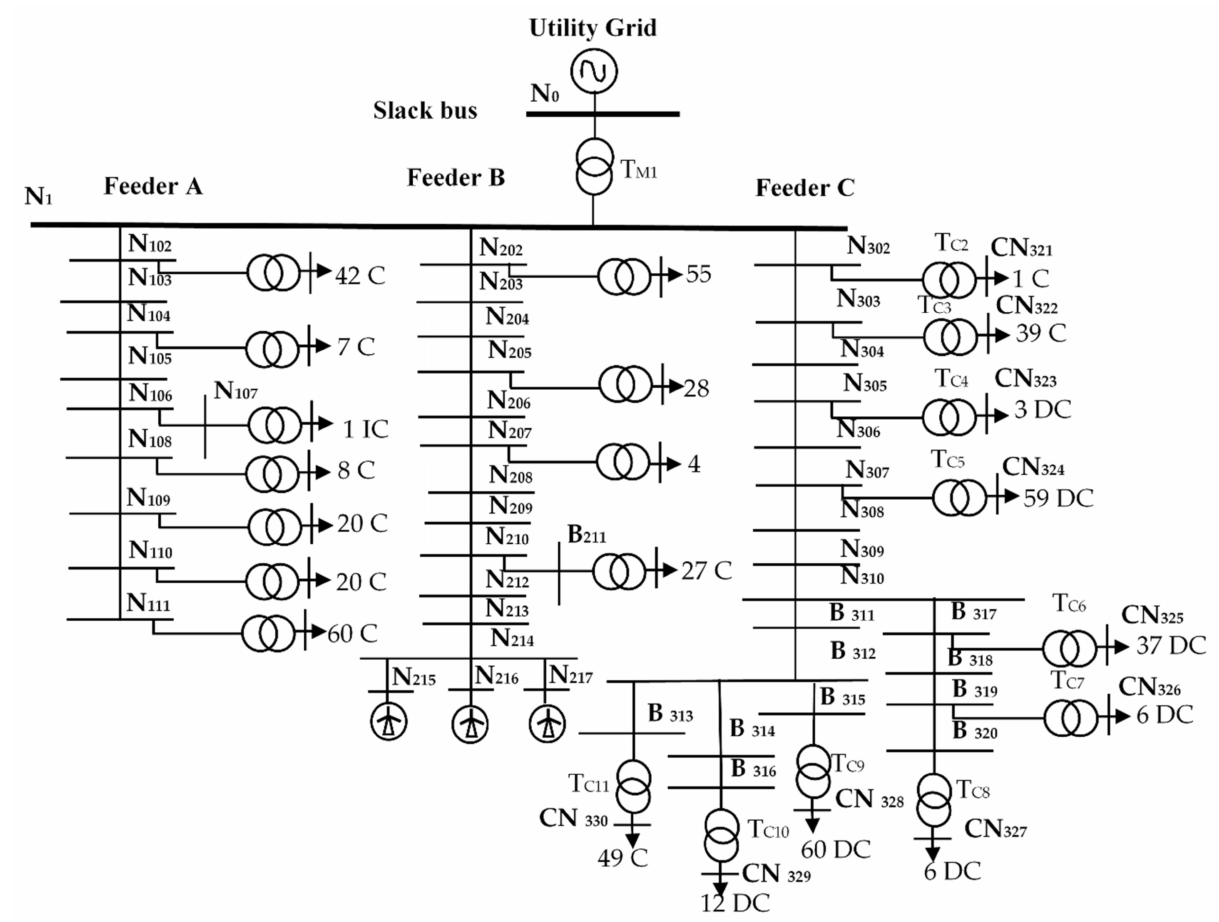
Figure 2. Single line diagram of feeder A, B and C with 272